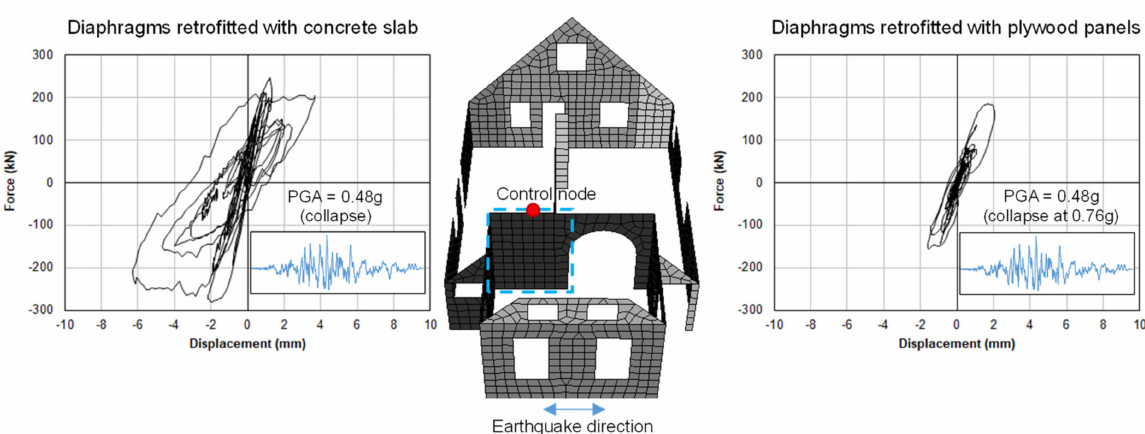
Figure 21. Comparison between the in-plane response of the most solicited wall under the application of signal 4 in configurations B1-RC ( left ) and B1-PP ( right ). When the concrete slab brings the wall to the in-plane capacity, for the same PGA, the dissipative plywood panel retrofitting prevents the pier from reaching its ultimate strength, which is retrieved at